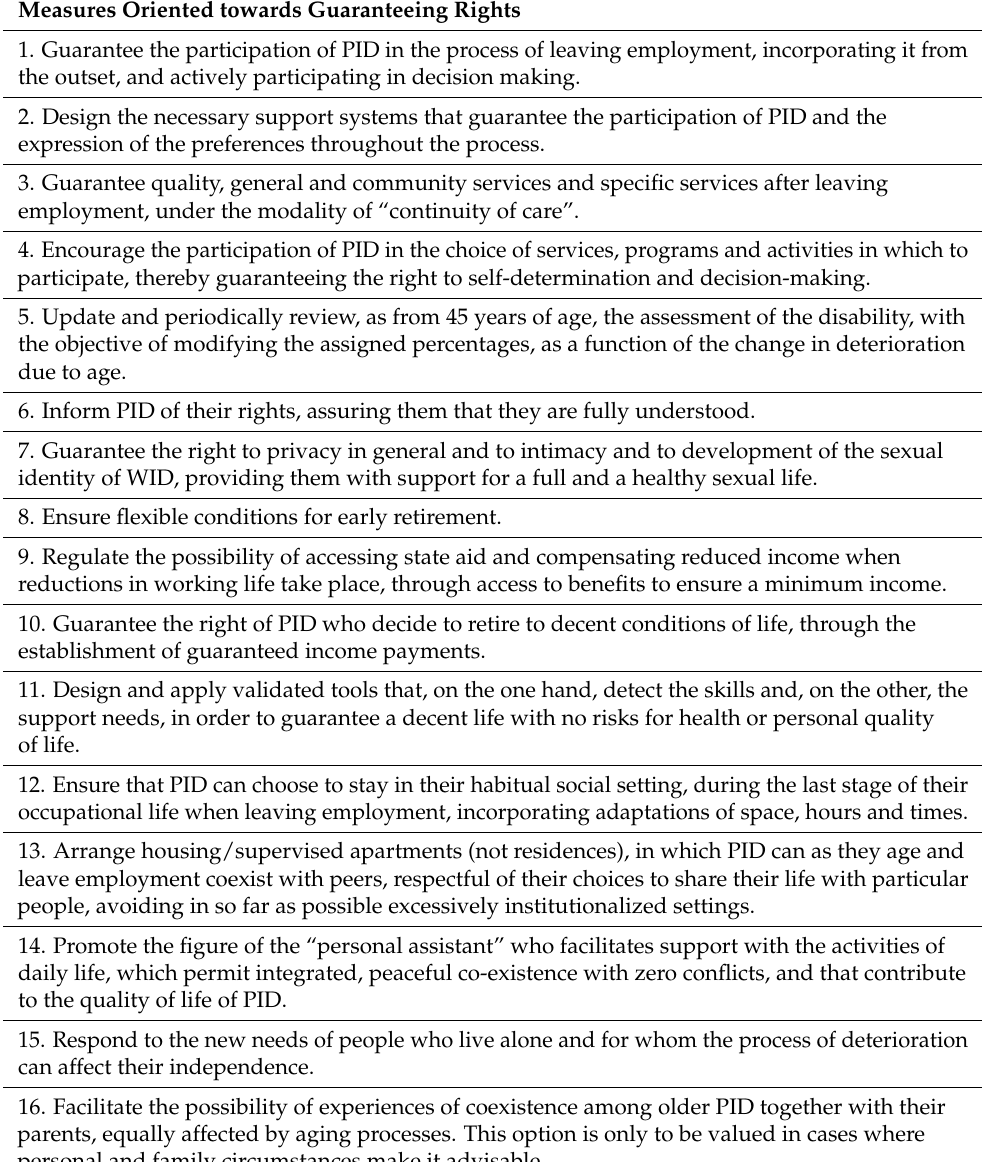
Table 7. Measures for Line of Action 2, referring to the guarantee of rights. Measures Oriented towards Guaranteeing